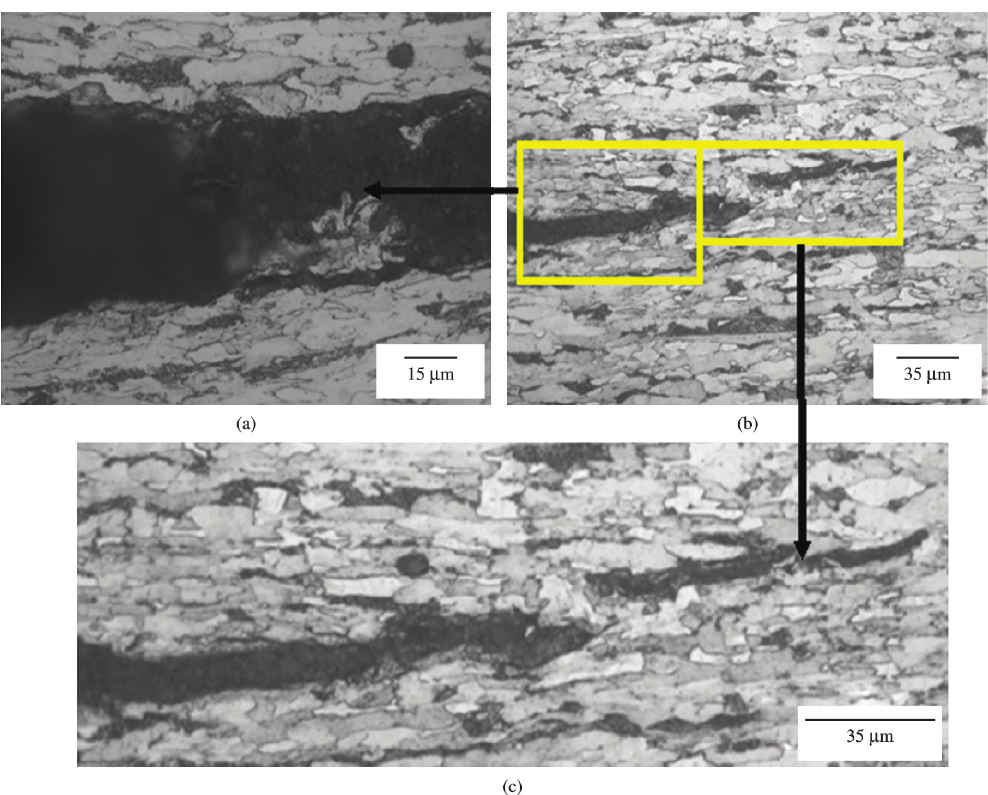
Figure 10. Microstructure of a perpendicular region to the fracture surface: a) separation of ferrite and pearlite; b) crack generated by delamination; c) change direction of crack